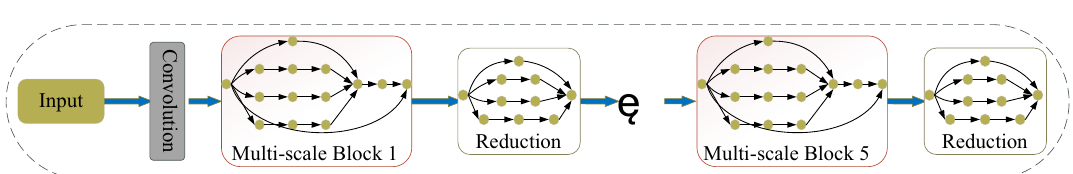
Figure 3. The architecture of MSB module. The input of MSB is the 256 × 256 × 1 ancient character image. The original image is first obtained by a simple convolution process to obtain the shallow features of the image, and then there are 5 consecutive multi-scale blocks, each of which is followed by a reduction